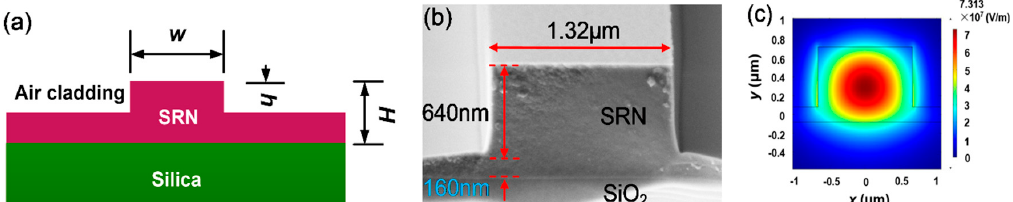
Figure 1. The fabricated silicon-rich nitride (SRN) ridge waveguide. (a) Schematic diagram of the structure. (b) Scanning electron microscopy image. (c) Simulated fundamental transverse-electric (TE 0 ) mode profile at 1950 nm of the waveguide with a width of 1.32 μ m and a rib height of 640 nm.